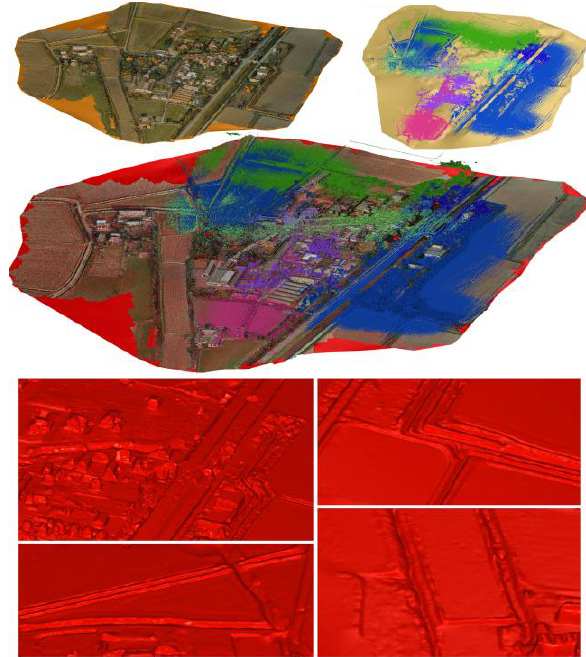
Figure 10. Comparison between DTMs from different point clouds. From above: on the left UAV's DTM, on the right MLS's DTM, at center the integrated database’s DTM, below integrated database DTM